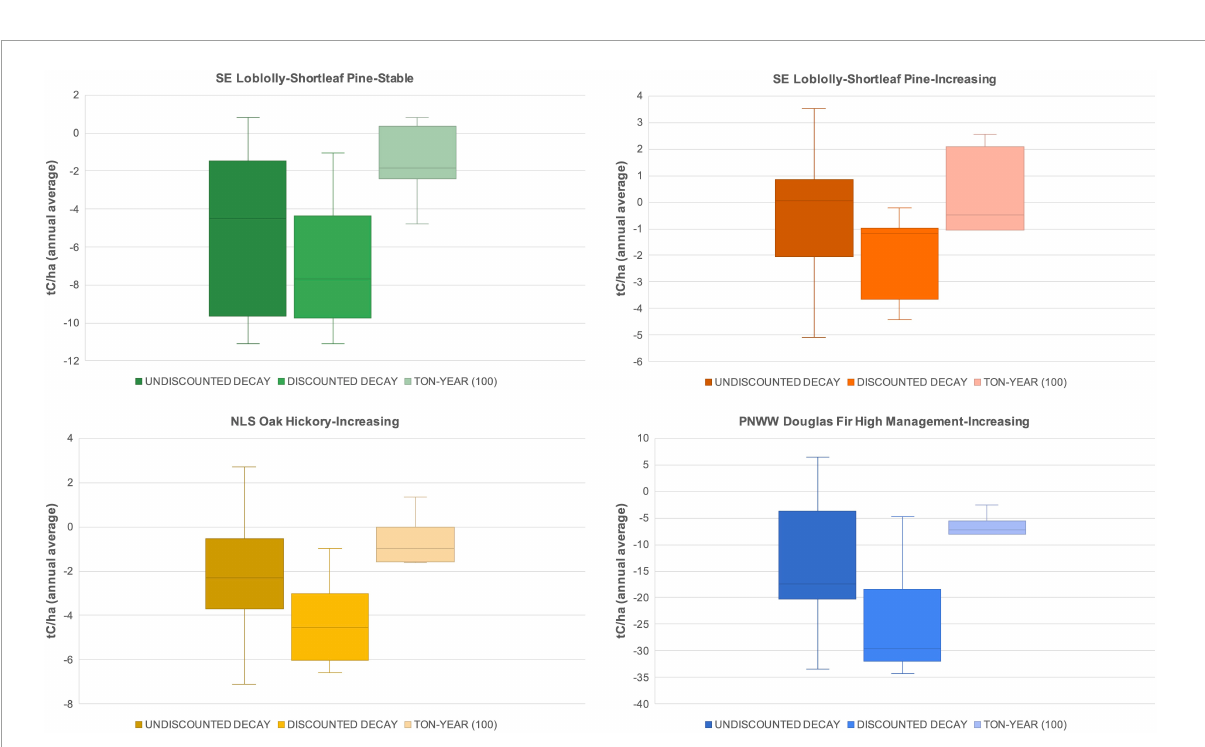
FIGURE3 Comparison of accounting approaches across project scenarios, showing average annual net sequestration by forest type and accounting approach, including all project lengths and project baseline scenarios (e.g., reforestation vs. conversion). “Increasing” and “Stable” reflect stand carbon accumulation at the time of harvest. Ton-year results reflect a 100-year time horizon. Negative values represent net sequestration relative to a baseline, immediate-harvest scenario.